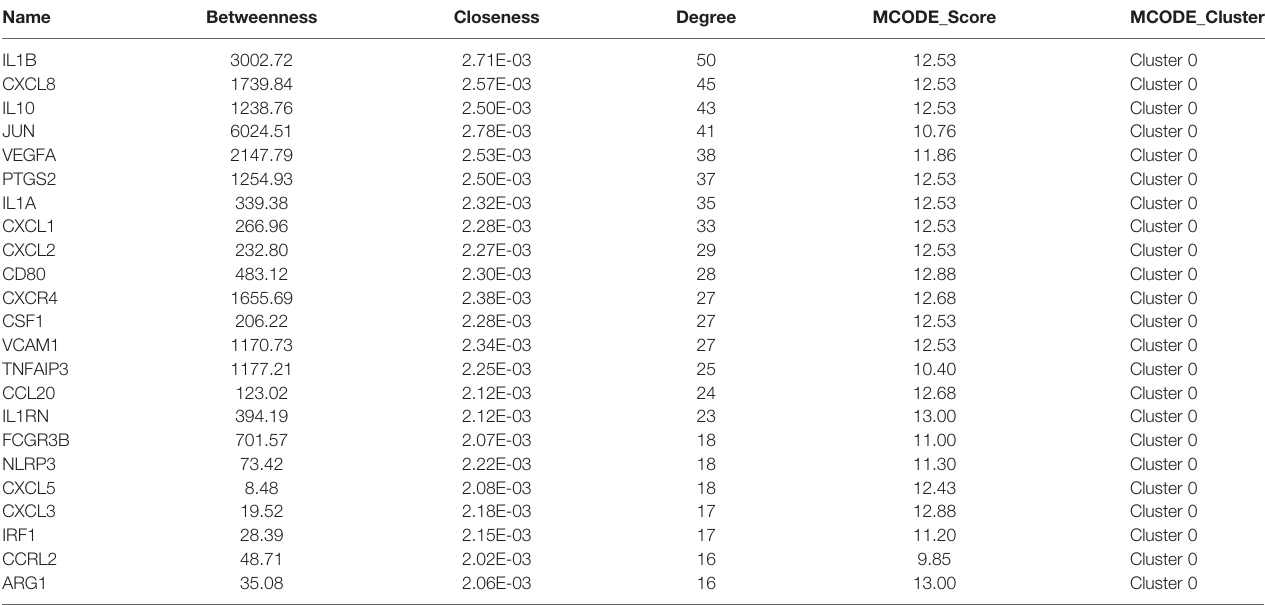
TABLE 1 | Results of Degree Centrality and MCODE analysis of up-regulated characteristic genes. Name